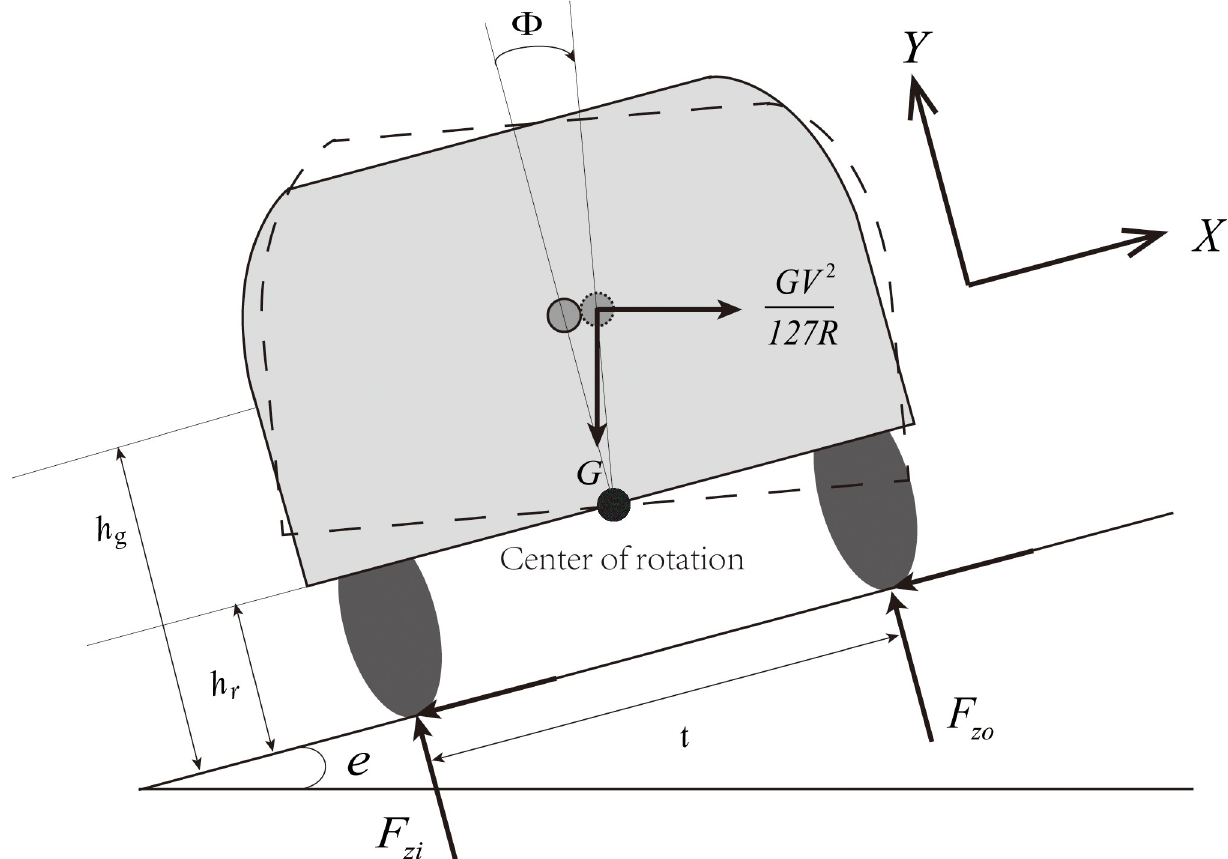
Fig 3. Vehicle model with suspension system.